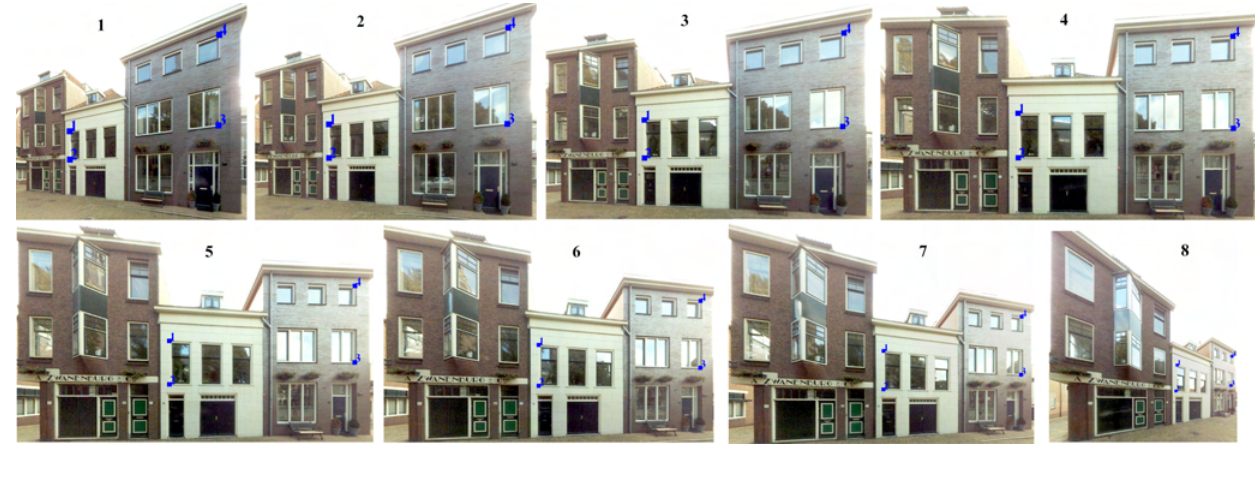
Figure 6. Locating occurrences of the same laser points in different image